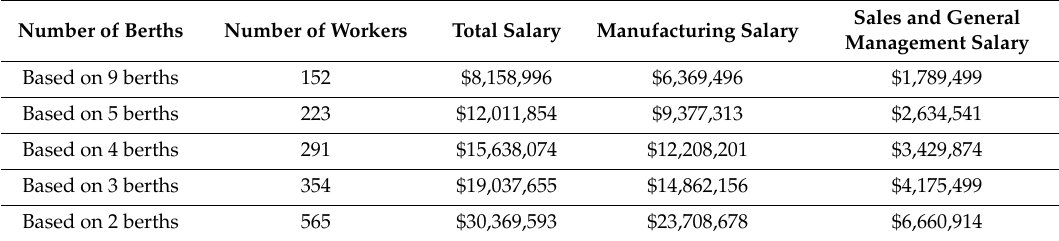
Table 5. Number of workers per berth and salary as of